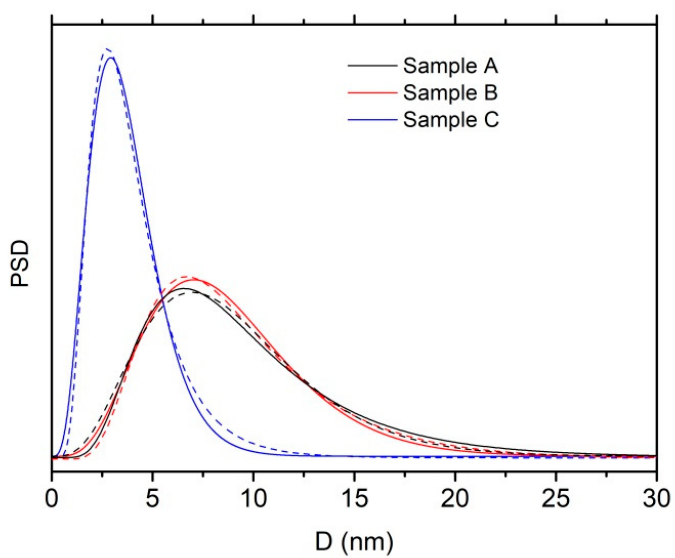
Figure 2. Solid line: domain size distributions of sample A, B and C obtained by the Pielaszek method. Dashed lines: fitting of the Gamma distribution functions with lognormal distributions. Table 2. For samples A, B and C, the averages of <D> determined by the Scherrer, Williamson-Hall, Pielaszek and Rietveld methods, the averages of σ obtained by the Pielaszek and Rietveld procedures and the relative standard deviations, σ /<D>, are also shown. The averages of the a 0 values derived by using the Scherrer and Rietveld methods are reported.